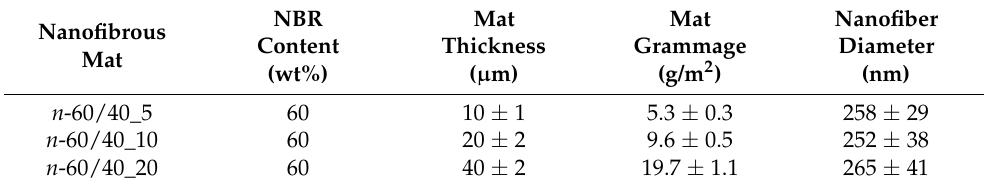
Table 1. Characteristics of electrospun rubbery